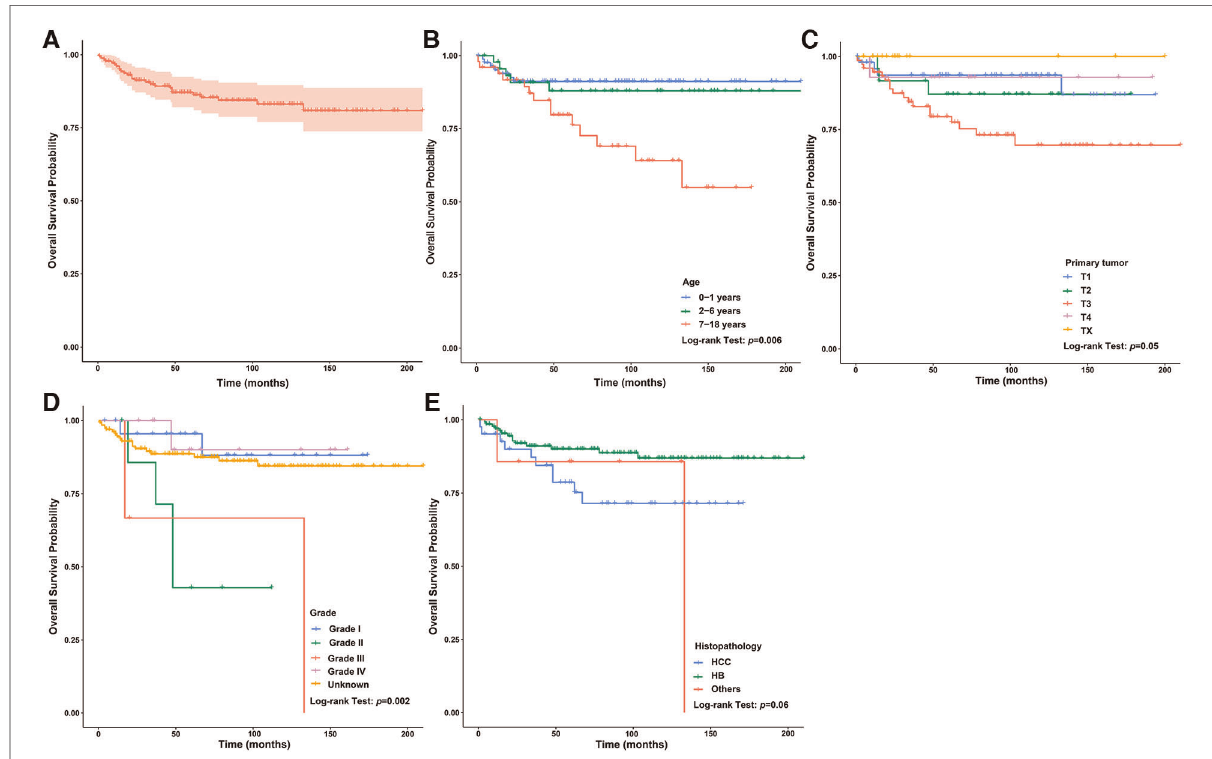
FIGURE 7 Survival curve of children with liver cancer treated with LT. ( A ) Survival curves of children with liver cancer treated with LT. ( B ) Survival curves of children with liver cancer treated with LT between different age of diagnosis groups. ( C ) Survival curves of children with liver cancer treated with LT between different T groups. ( D ) Survival curves of children with liver cancer treated with LT between different grade groups. ( E ) Survival curves of children with liver cancer treated with LT between different histopathology groups. LT, Liver